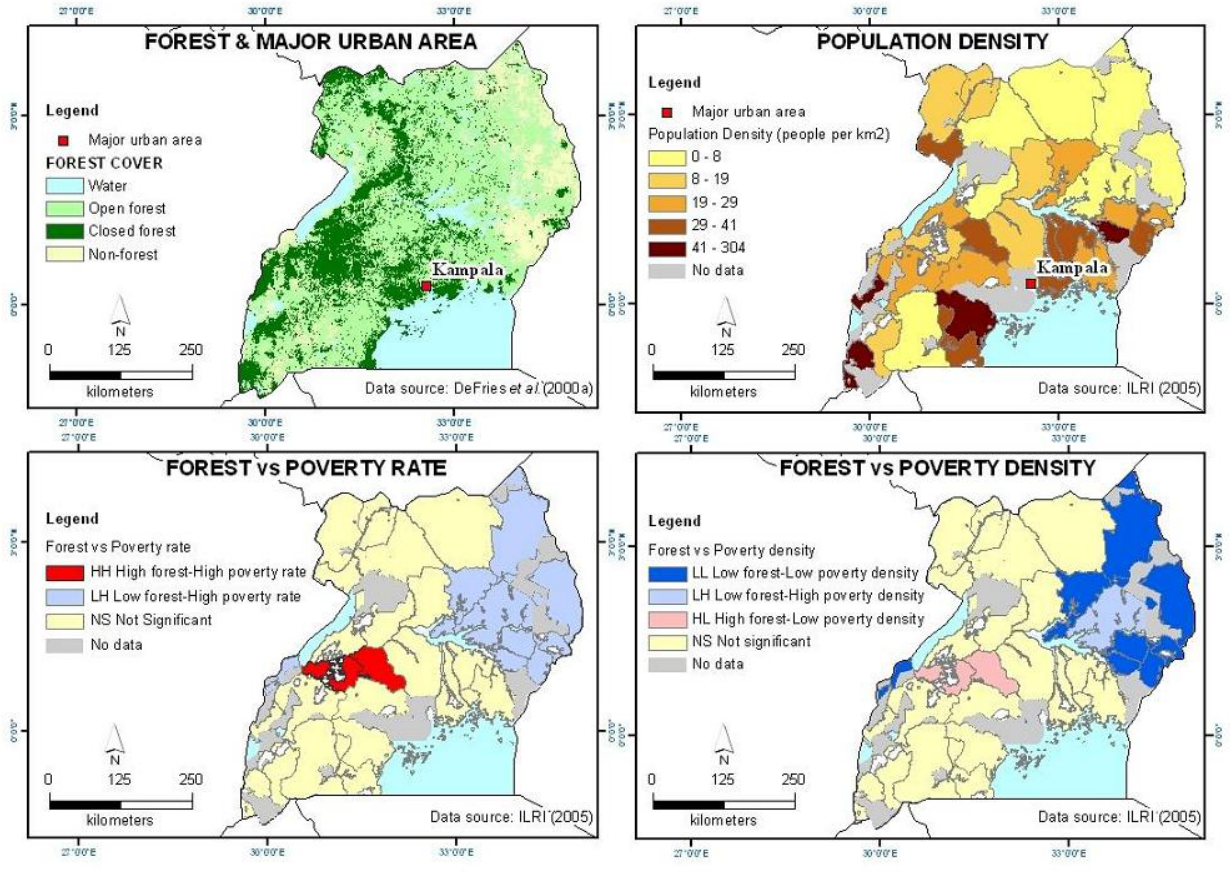
Fig. 5. Uganda. Maps of forest and major urban areas, population density, local indicators of spatial association (LISA) analysis of forest cover by poverty rate, and LISA analysis of forest cover by poverty